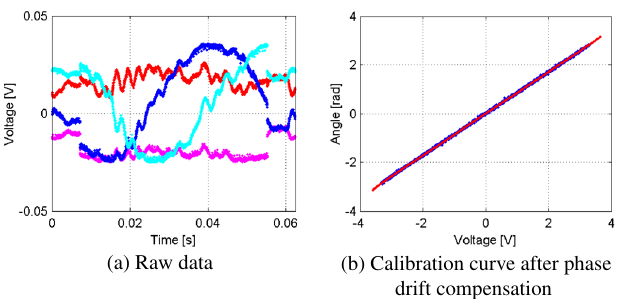
FIG. 10. In situ calibration of a phase EOM using reference pulses and phase-drift compensation. (a) Raw data collected while the modulation voltage is swept from − 3 . 5 V to 3.5 V within the time window (5 – 58 ms). Red line: In-phase value of the reference pulse. Magenta line: Quadrature value of the reference pulse. Blue line: In-phase value of the phase-modulated pulse. Cyan line: Quadrature value of the phase-modulated pulse. (b) The calibration curve between the applied voltage and the induced phase after phase-drift compensation. Blue dots: Cali- bration data. Red line: Polynomial